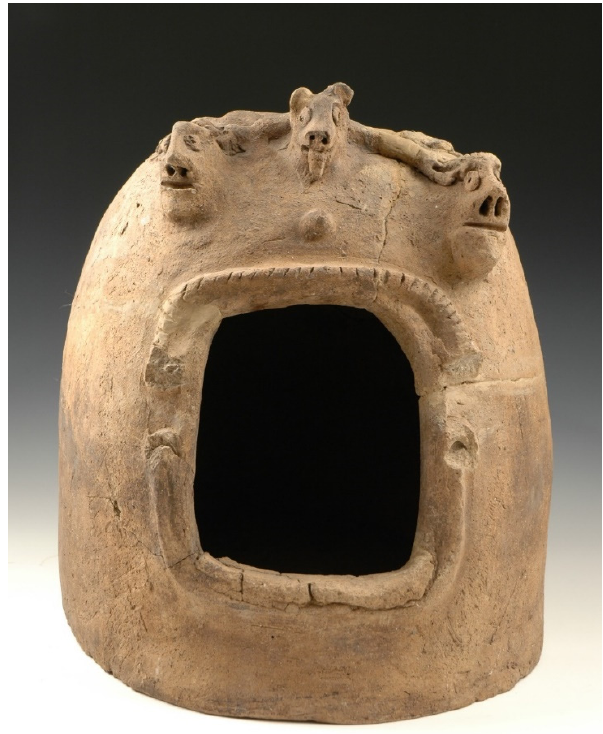
Figure 9. Pottery portable shrine from Tel Rehov, Israel, dated to the 9th century BCE (courtesy of Amihai Mazar, photograph by D. Harris).